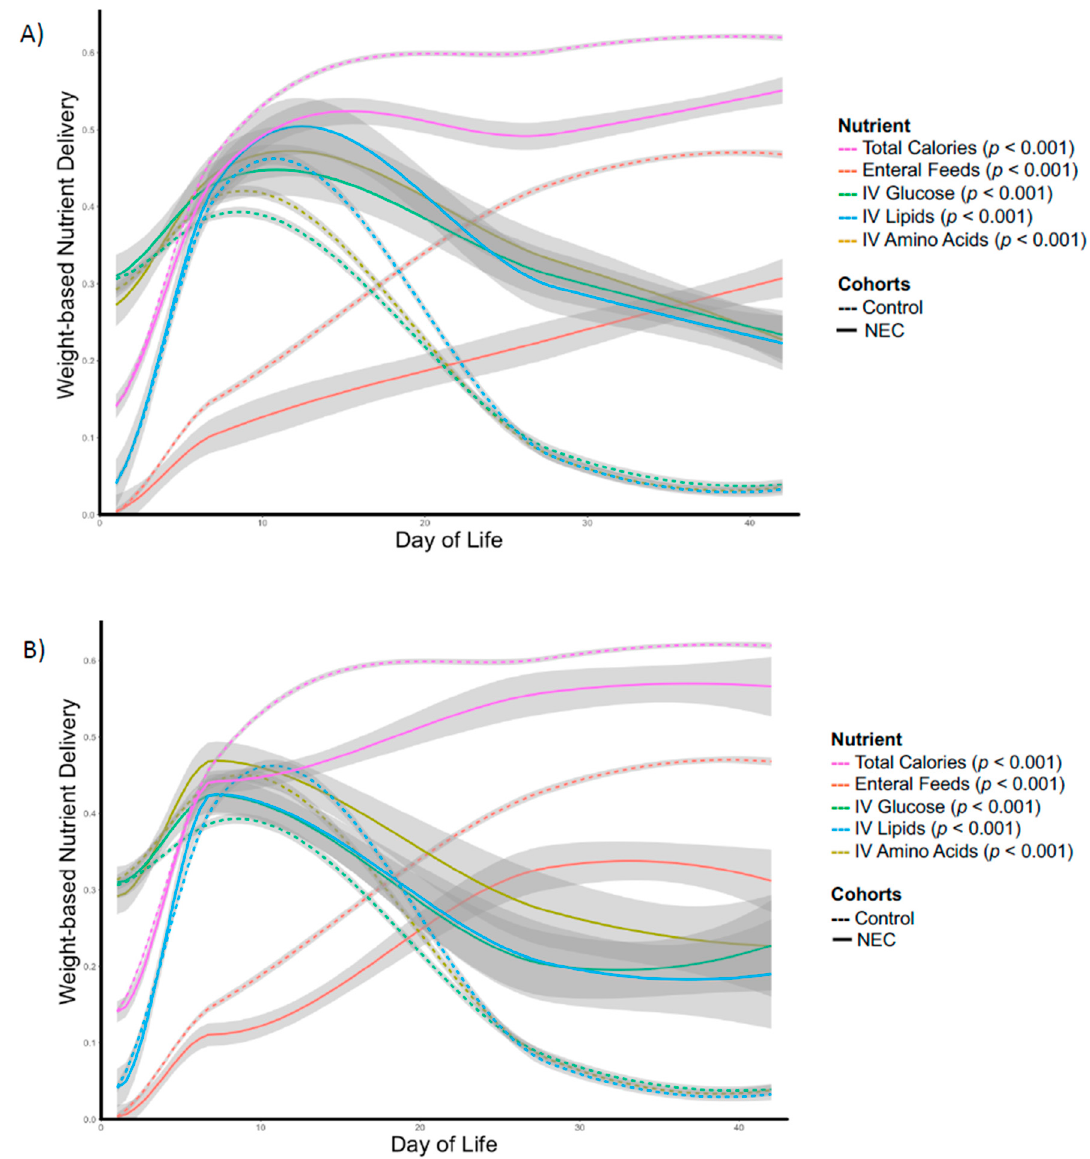
Figure 3. Longitudinal comparison of nutrients administered over the first 6 weeks of life between necrotizing enterocolitis (NEC) case and control infants: ( A ) Entire NEC cohort, ( B ) NEC cohort using only data obtained prior to NEC diagnosis.